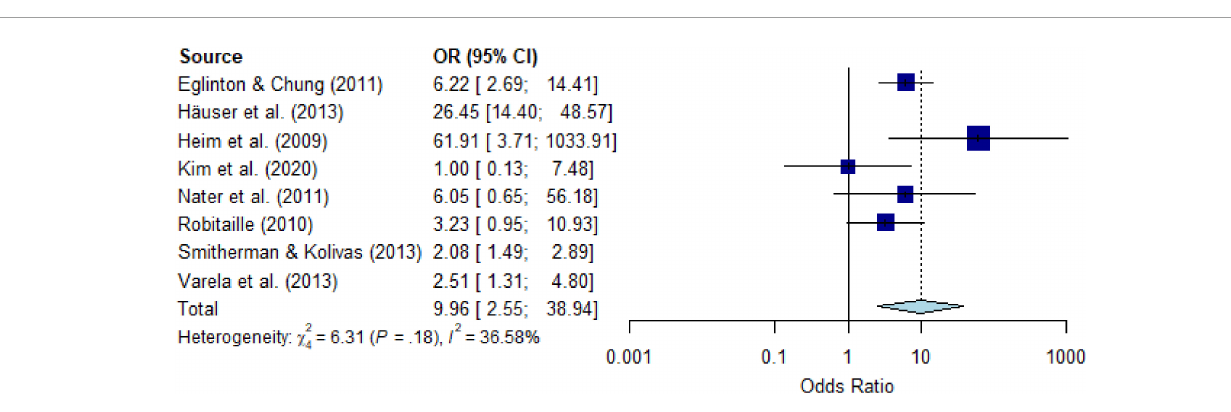
FIGURE6 Forest plot of point prevalence of post-traumatic stress disorder (PTSD) in people with chronic somatic diseases (CD) compared with controls without chronic somatic diseases (CD), after eliminating